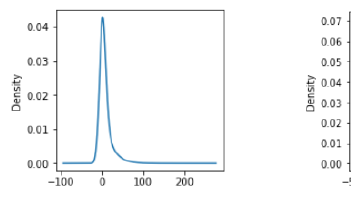
Figure 13. Density